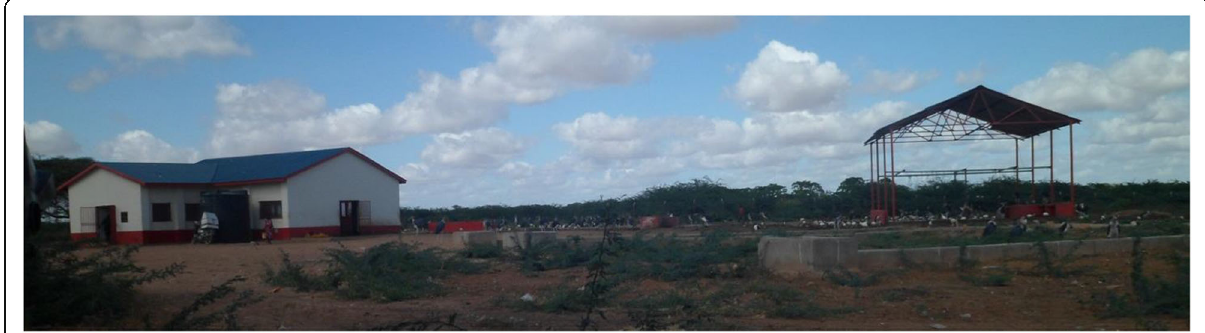
Fig. 3 Pictorial representation of an enclosed slaughterhouse for goats and sheep (left) and an open slaughterhouse for cattle and camel (right)